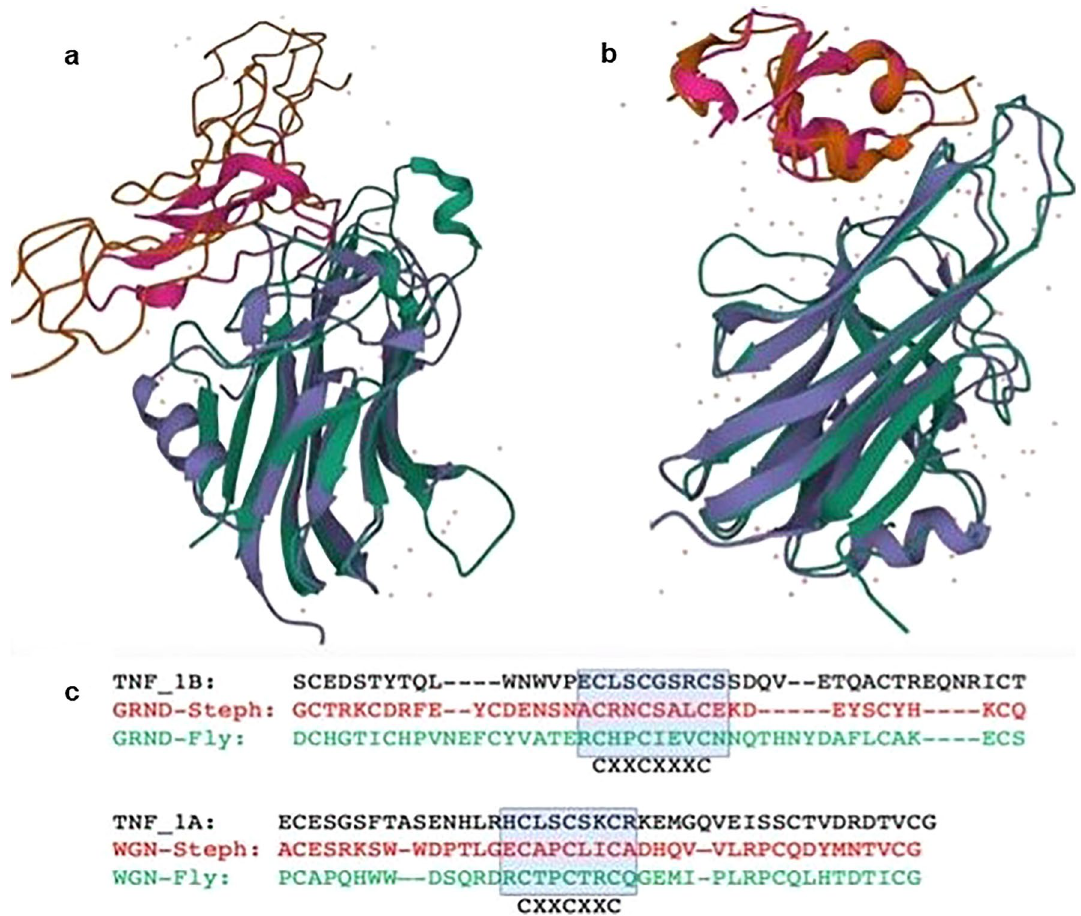
Figure 3. ( a ) De novo model of Eiger and comparative model of Wengen superimposed on the crystal structure of the complex of TNFb-TNFR-1A (1tnr). ( b ) De novo model Eiger and comparative model of Grnd superimposed on the crystal structure of the complex of Eiger and Grnd from Drosophila (6zt0). ( c ) Sequence alignment of Wengen and Grnd against TNFR-1A, -1B and Grnd from Drosophila used in comparative